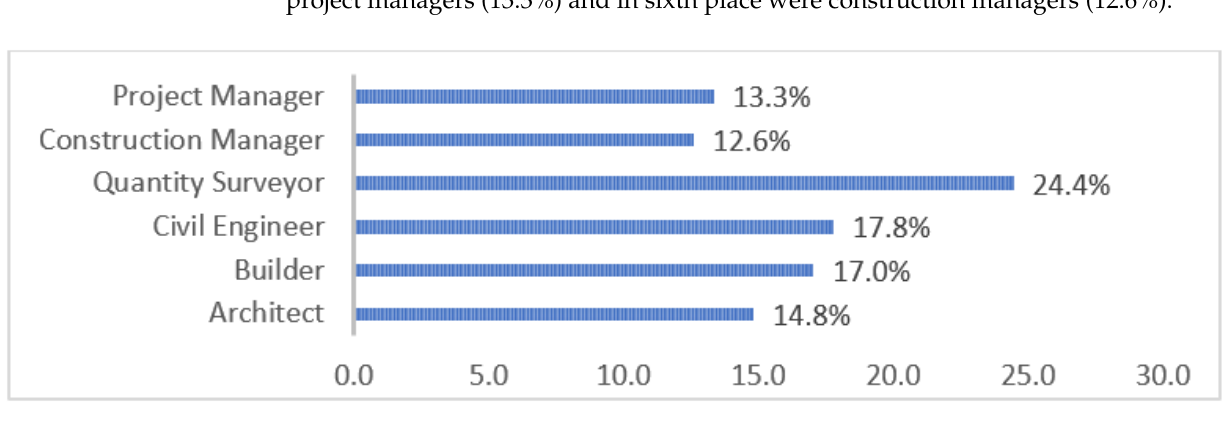
Figure 1. Respondent’s professions.